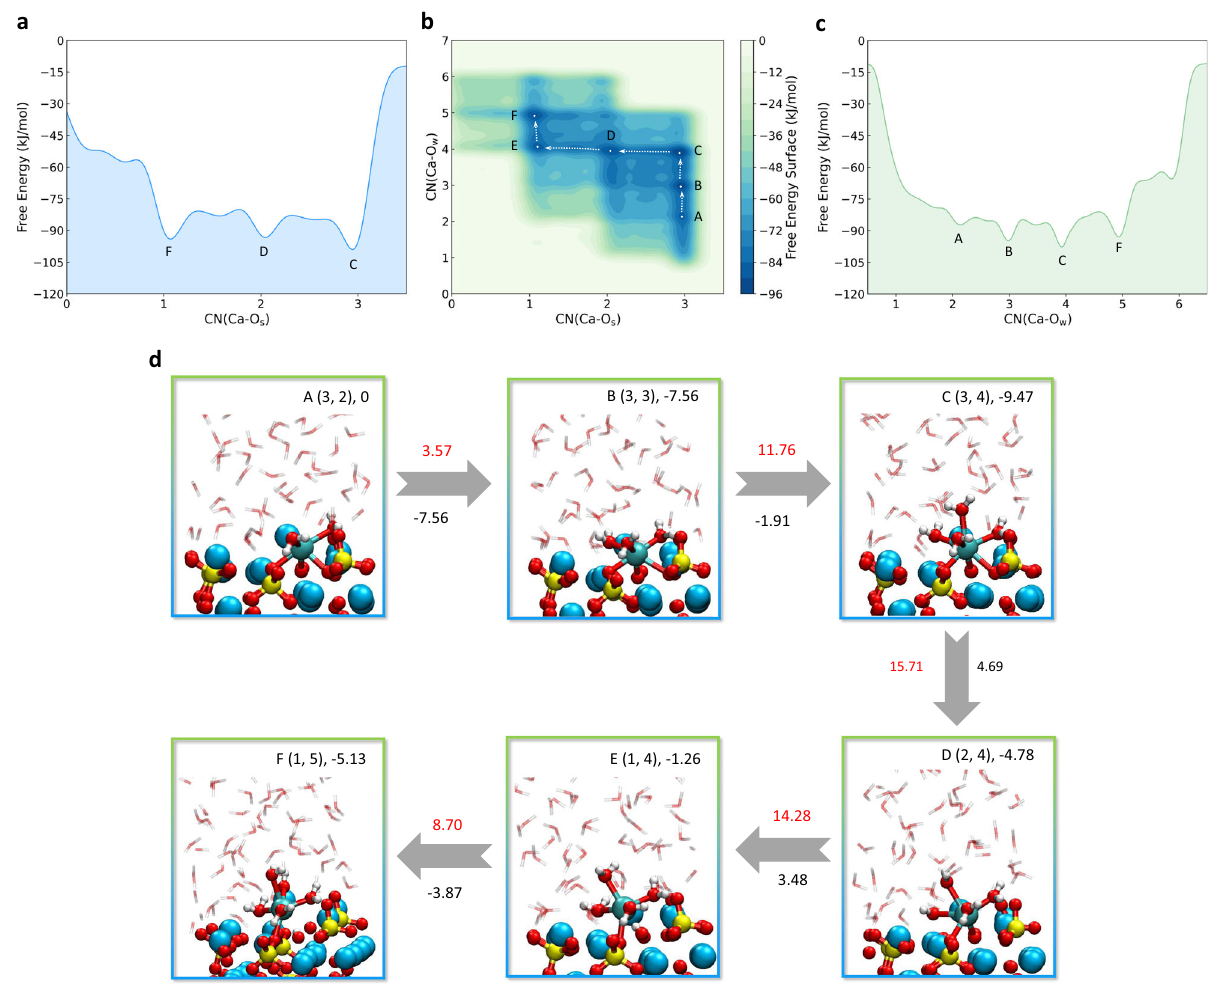
Fig. 2 Dissolution mechanism of Ca α from the Ca 3 SiO 5 surface. a , c The one-dimensional free energy pro fi les with respect to CN(Ca – O s ) and CN(Ca – O w ), respectively. b The two-dimensional free energy surface with variables of CN(Ca – O s ) and CN(Ca – O w ). d The con fi gurations of the free energy minimum states on the FES and the corresponding reaction pathways. The state number, coordinates on the FES and the Helmholtz free energy values (kJ/ mol) relative to state A are at the upper right. The values in red are free energy barriers (kJ/mol) and the values under the arrows in black are overall changes in free energies between two states (kJ/mol). The yellow, blue, cyan, red, and white spheres are indicted to the silicon, calcium with no bias potential, calcium with bias potential, oxygen and hydrogen ions, respectively. For simplicity, the solute is shown in the transparent stick